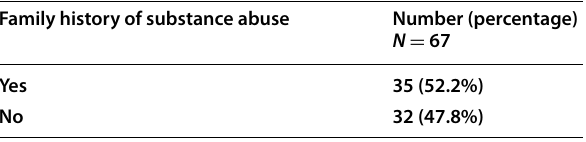
Table 2 Age distribution and sociodemographic characteristics Table 3 Family history of substance abuse among the studied